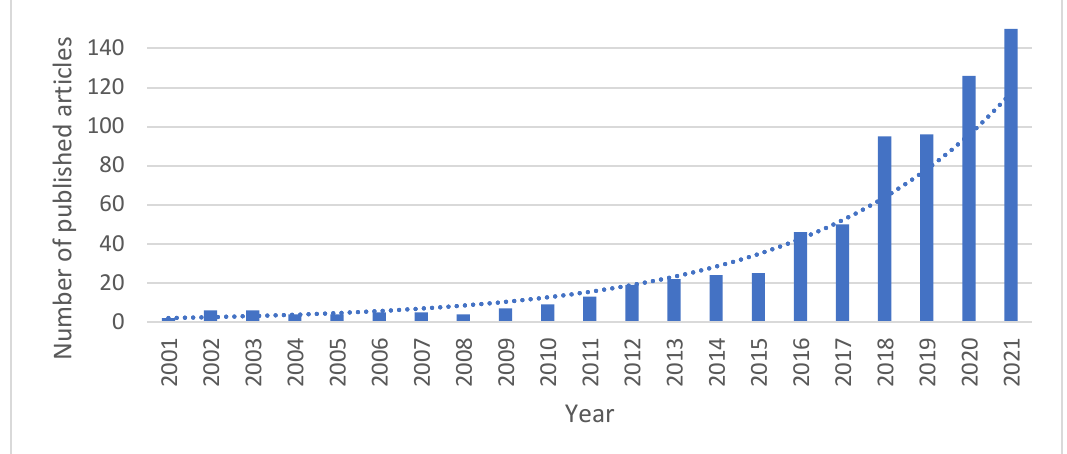
Figure 1. Articles published on bPV technology over the last 20 years with the key word “bifacial photovoltaic” (Source: Scopus).